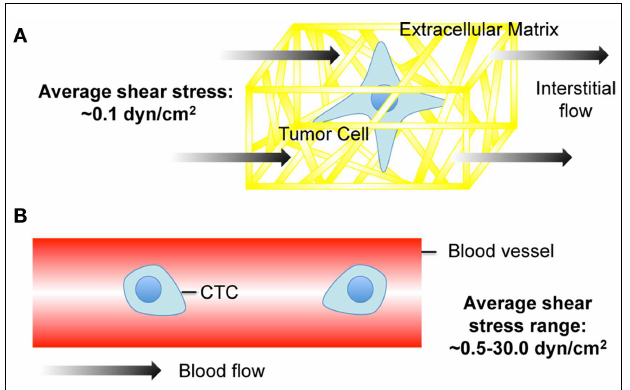
FIGURE 1 | Cancer cell exposure to the tumor and vascular microenvironments. (A) Tumor cell exposed to interstitial flow in a collagen matrix (Swartz and Fleury, 2007). (B) Circulating tumor cell (CTC) exposed to fluid shear forces in a blood